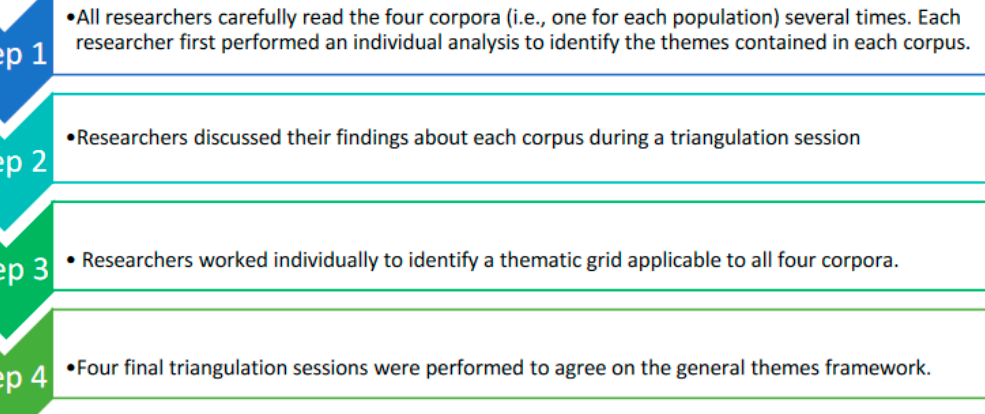
Figure 1. Thematic analysis process.